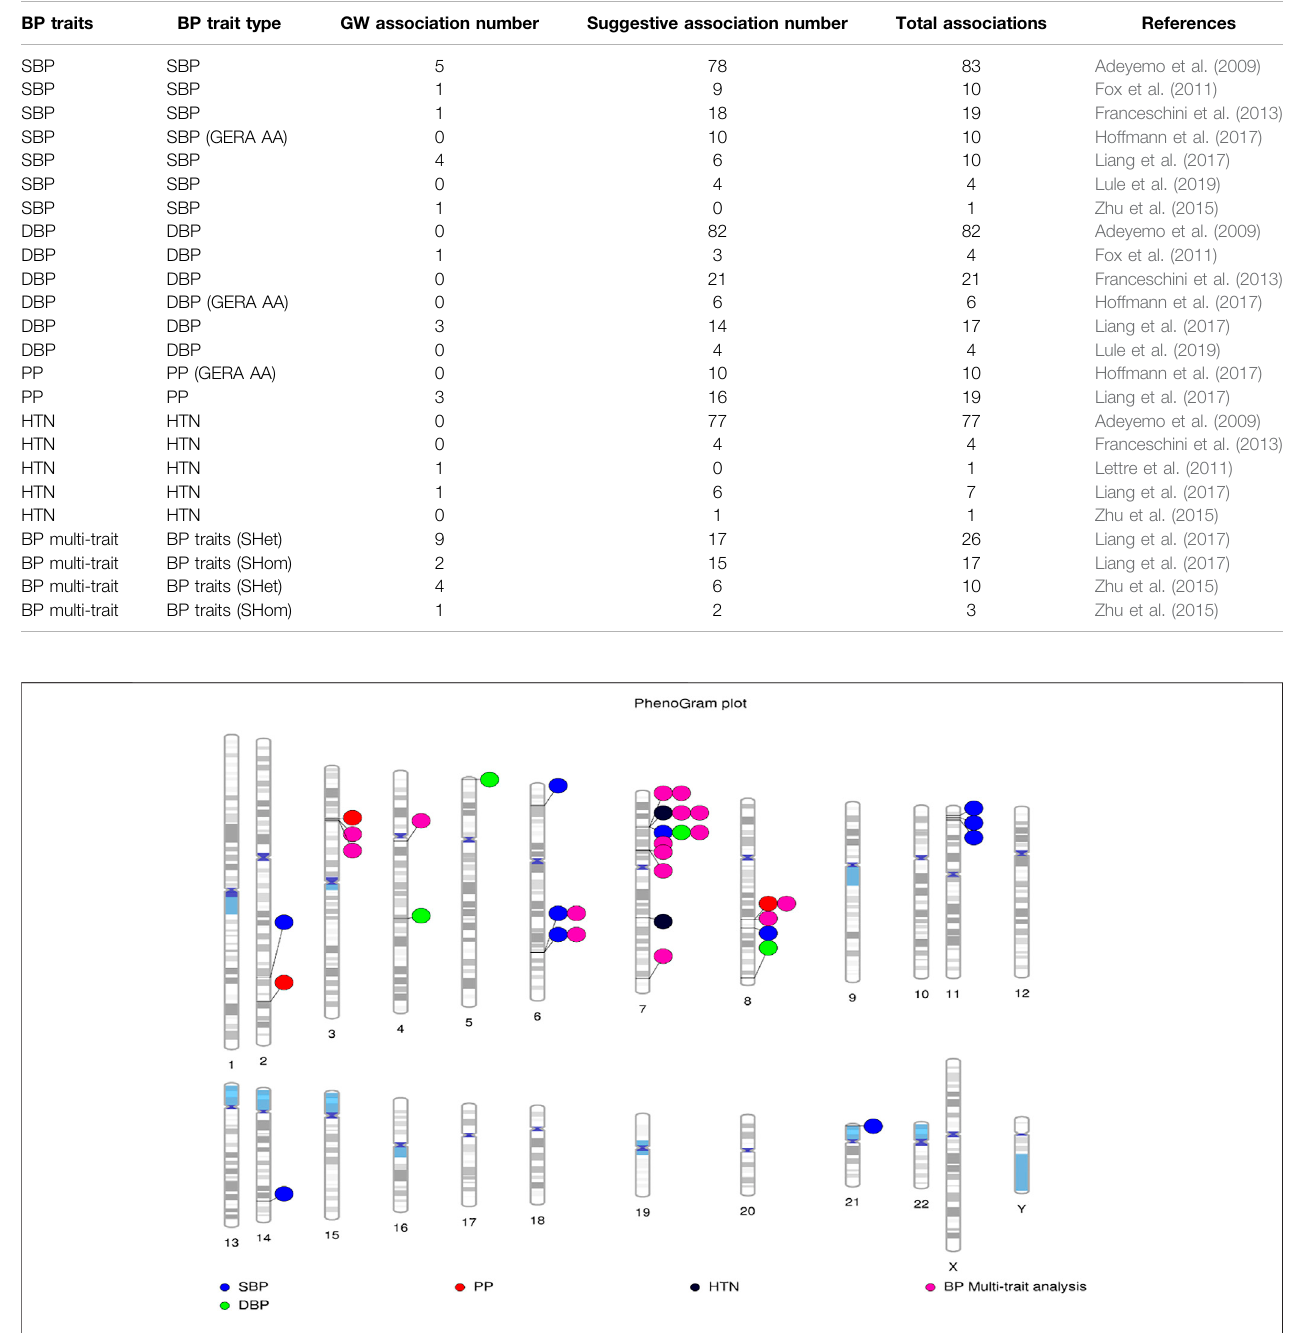
Frontiers in Genetics |